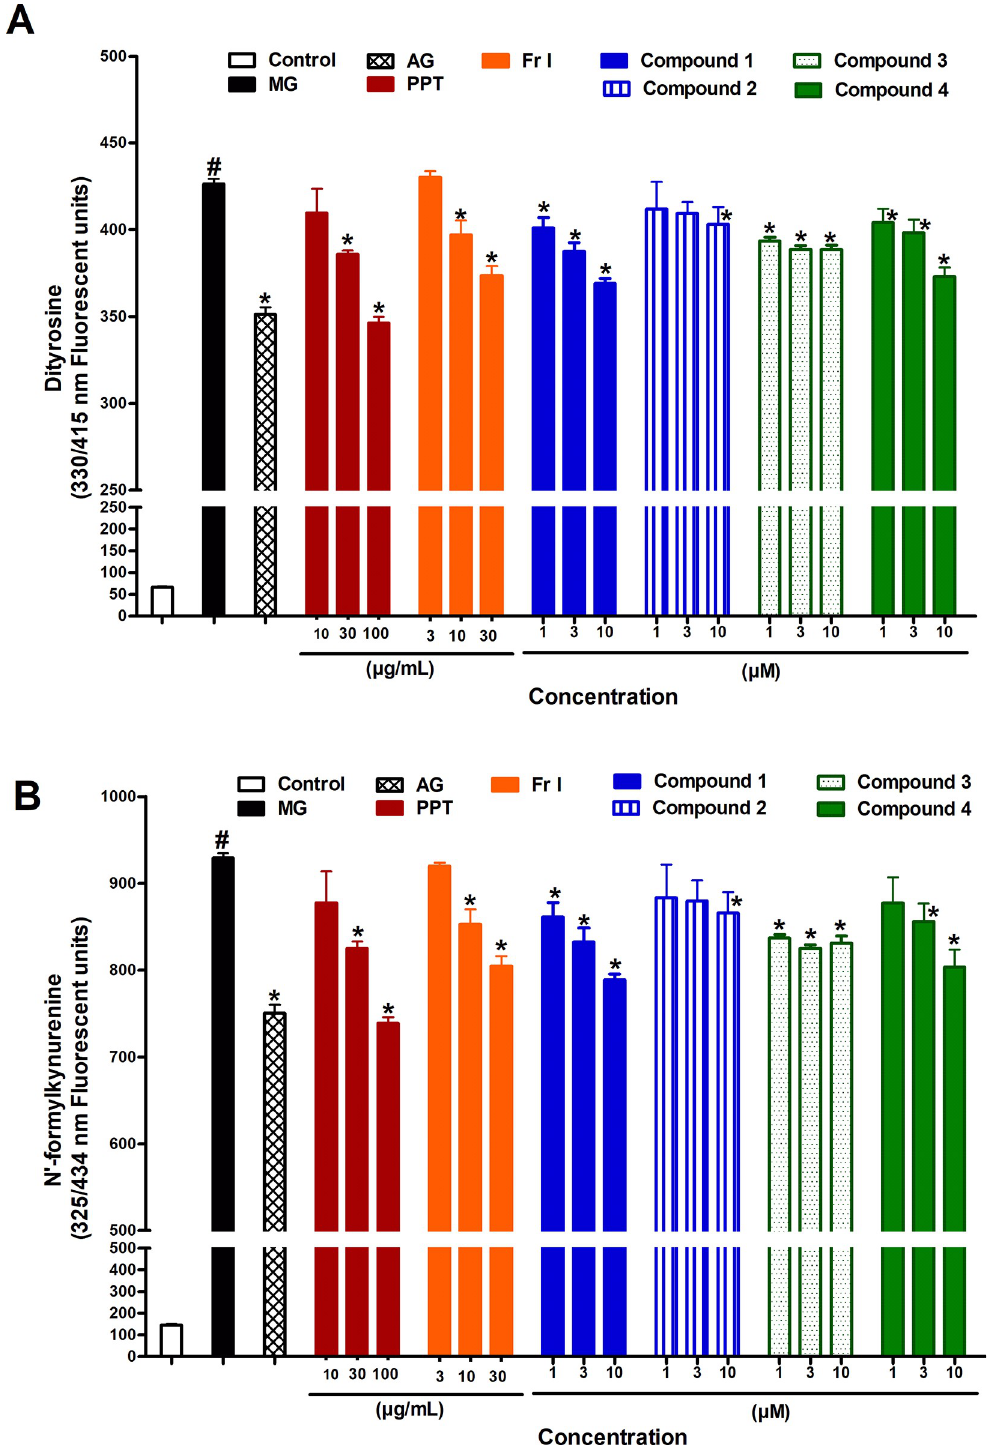
Fig 5. Effect of different concentrations of PPT, bioactive fraction (Fr. I), and isolated compounds 1–4 on the formation of fluorescent dityrosine (A) and N‘-formylkynurenine (NFK), (B) when BSA is incubated with MG for one hour. AG was used as standard anti AGEs drug. Results are expressed as mean ± SEM (n = 3). # p < 0.05 when compared to control group, � p < 0.05 when compared to MG group; by Two Way ANOVA and Bonferroni post hoc test.